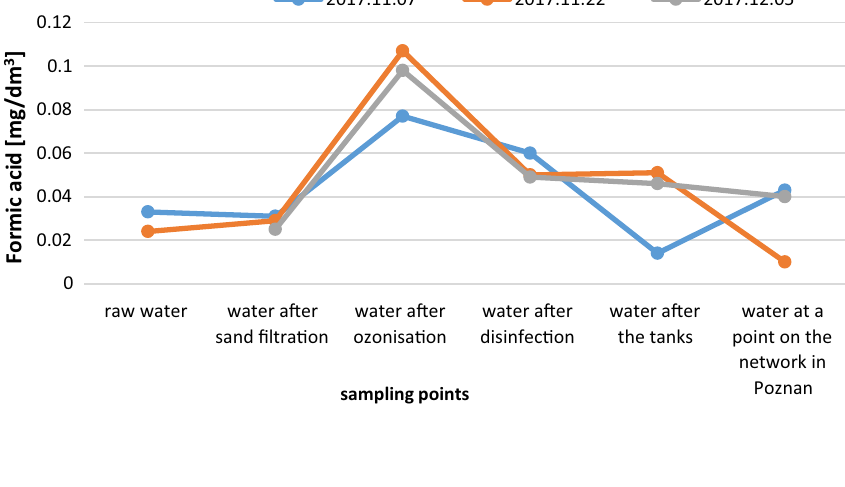
Fig. 10 Carboxylic acids concentration at points on the PWSS in 2014 (before mod- ernisation), in 2015 (a few days after activation of ozonation and GAC filtration) and in 2019 (after 4 years of